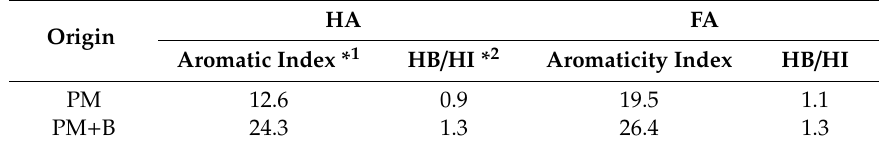
Table 4. Aromatic Index and Hydrophobicity (HB / HI) of humic acid-like (HA) and fulvic acid-like (FA) extracted from poultry manure compost (PM) and poultry manure blended with biochar (PM +